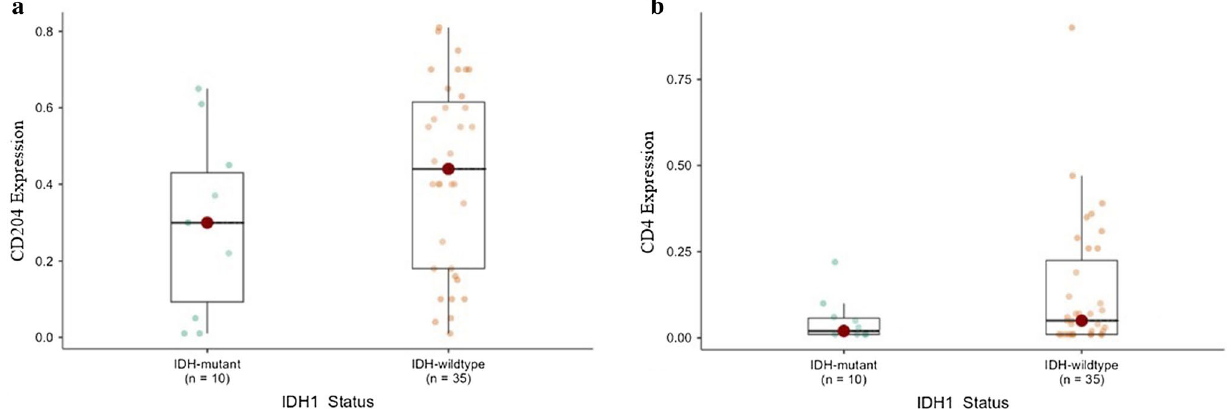
Fig. 5 Correlation between CD204 + TAMs and CD4 + TILs with IDH1 mutation in glioblastomas. A high expression of CD204 + TAMs with a low expression of CD4 + TILs was associated more with IDH1 wildtype glioblastomas Table 6 The inverse relationship of CD204 + TAMs and CD4 + TILs with IDH1